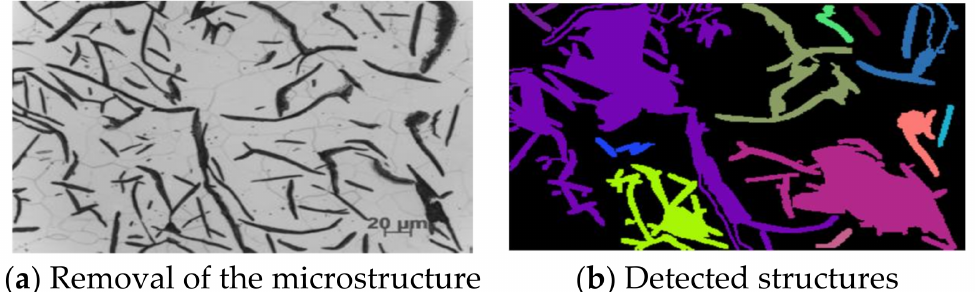
Figure 6. Canny Filter Operation. Each detected structure is marked with a different